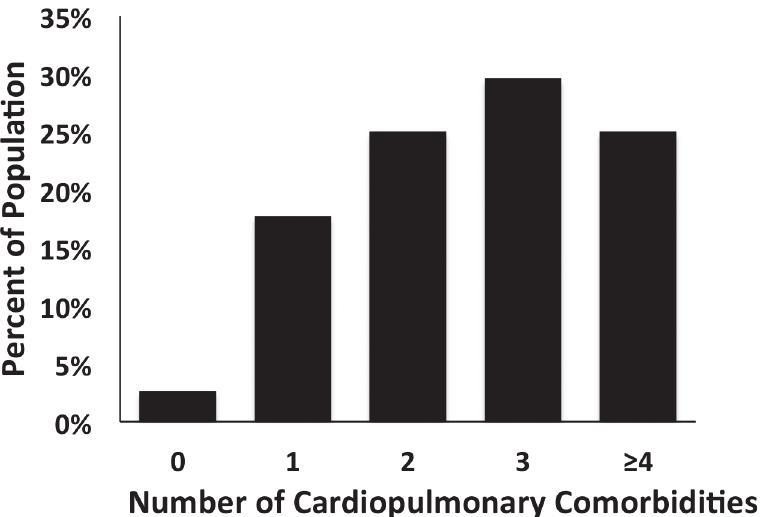
Fig 1. Distribution of cardiopulmonary comorbidities in patient cohort (n = 152), cardiopulmonary co- morbidities include greater than moderate left-sided valvular disease, coronary artery disease, heart failure, pulmonary embolus, chronic obstructive pulmonary disease and pulmonary